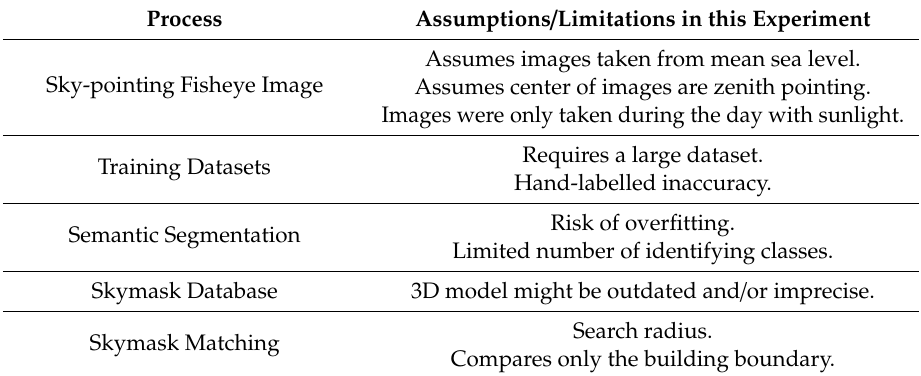
Table 6. Summary of the limitations of the proposed skymask matching